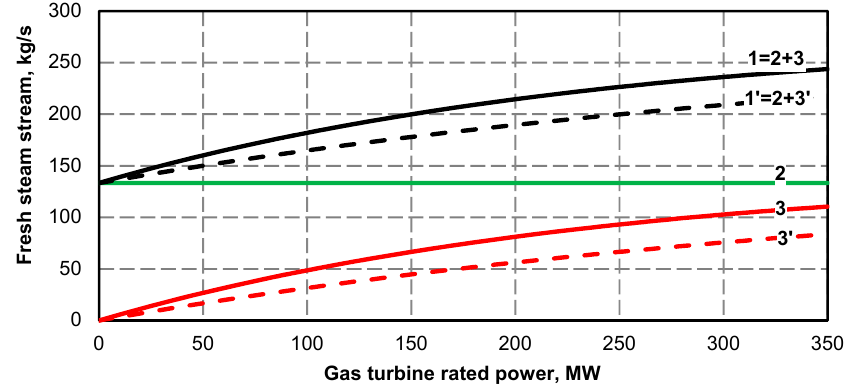
Figure 37. Fresh steam streams as a function of gas turbine rated power at a minimum steam boiler output of 133.3 kg/s: 1, 1’ — steam streams fed to the steam turbine, 2 — steam stream generated in the steam boiler at its minimum efficiency, 3 — steam stream generated in the recovery boiler for gas turbine operating at its rated power, 3’– steam stream generated in the recovery boiler for gas turbine operating at 60% of its rated power.